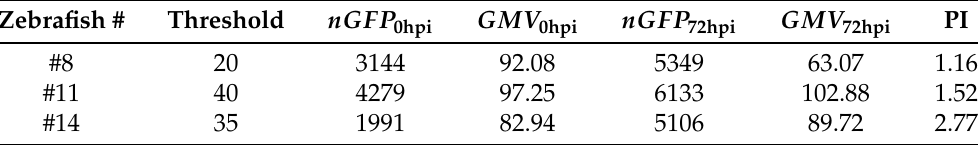
Table 1. Final thresholds and measurements of areas and mean green value for zebrafish #8 (dissemi- nation, PI around 1), #11 (proliferation, PI greater than 1), and #14 (proliferation and dissemination, PI greater than